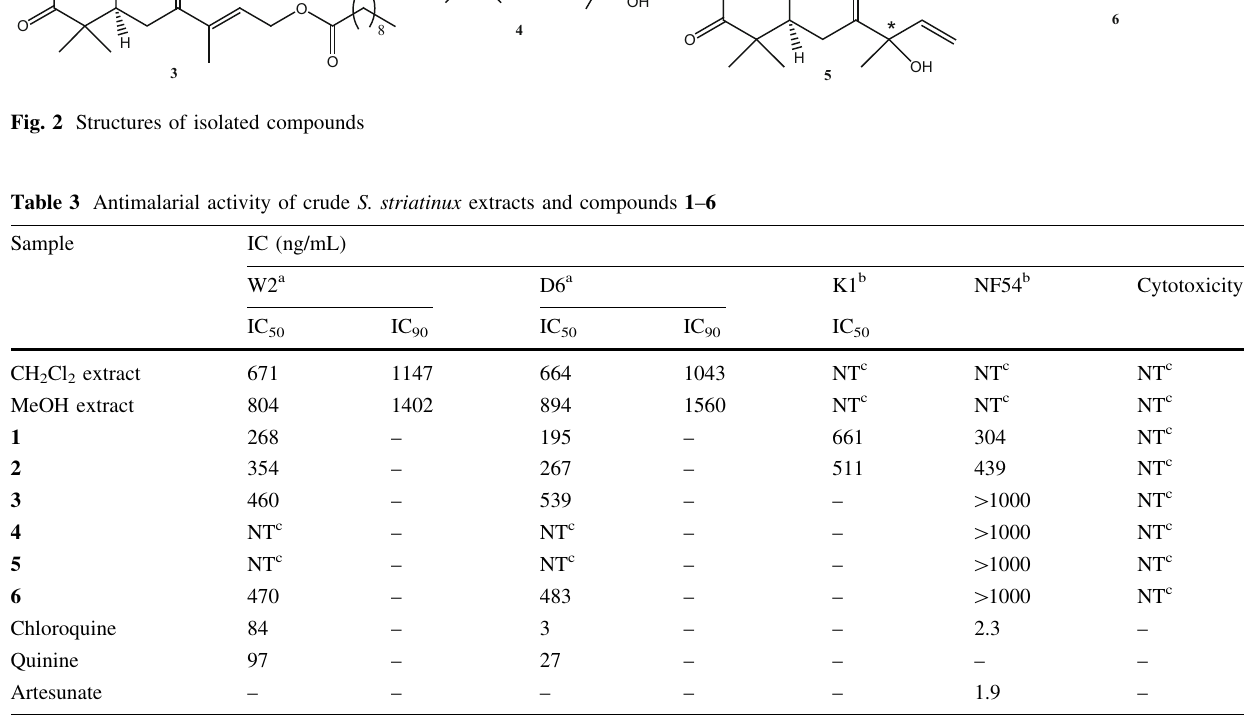
Results are a mean of 2–3 determinations and individual measurements differed by less 50% a Results obtained from WRAIR b Results obtained from STI c